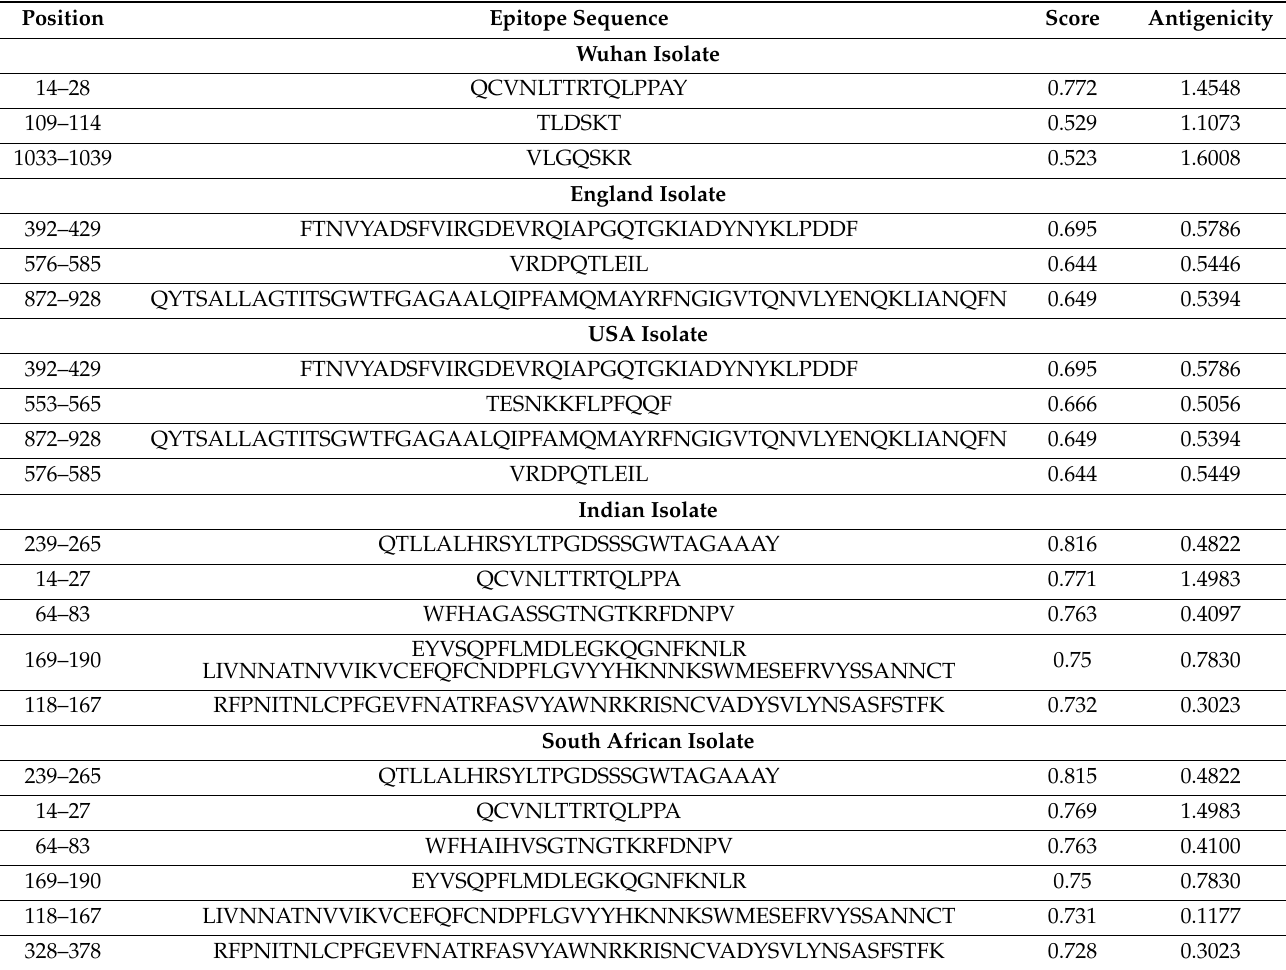
Table 4. Potential linear B-cell epitopes identified in each variant predicted by